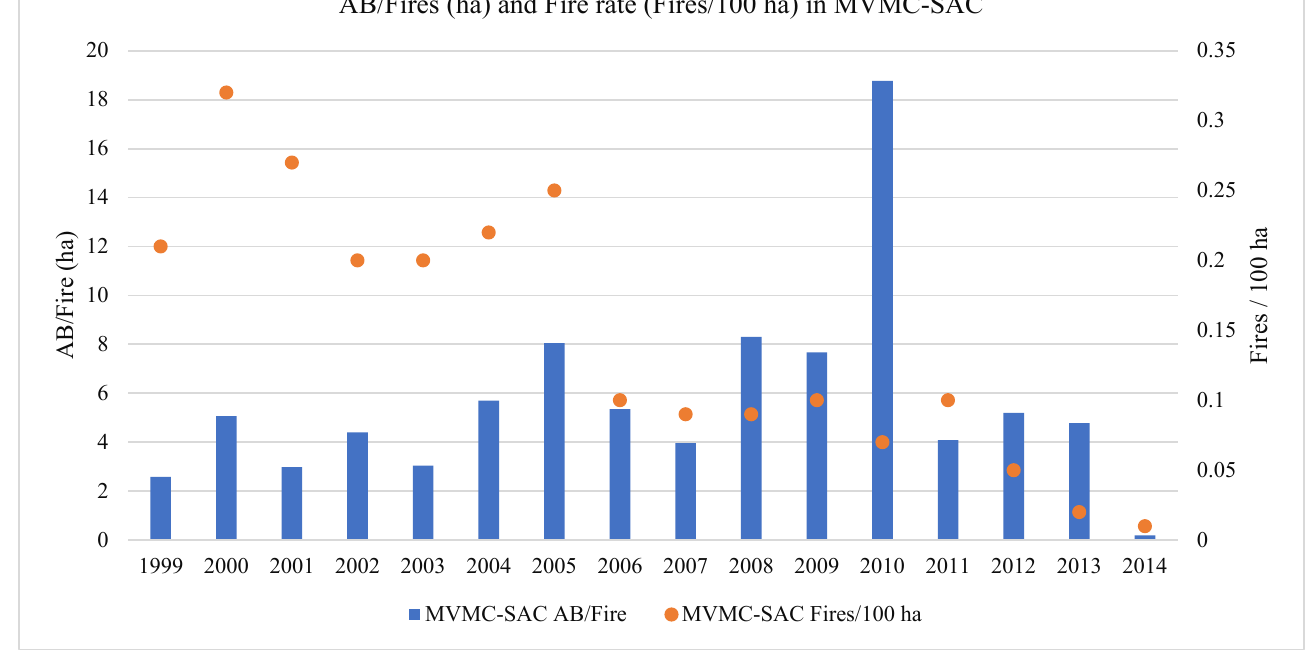
Figure 14. The area burnt per fire (AB/fire) and the rate of fires per 100 ha (orange dots) in the MVMC-SAC during the study period. The decrease in the fire rate is similar to that observed in Galicia. Except for a very remarkable increase in 2010, no major differences were seen in the area burned by fire. Table 5. Significant differences in the rate of forest fires and in the area burned by fire (BA/wild- fire) in MVMC with SAC, before and after 2004.